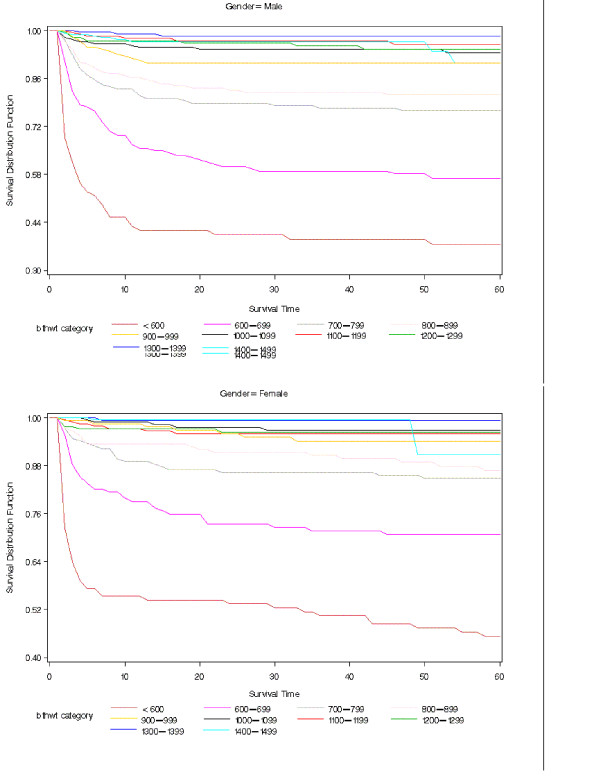
Actuarial survival curves stratified by birth weight category; by Gender.